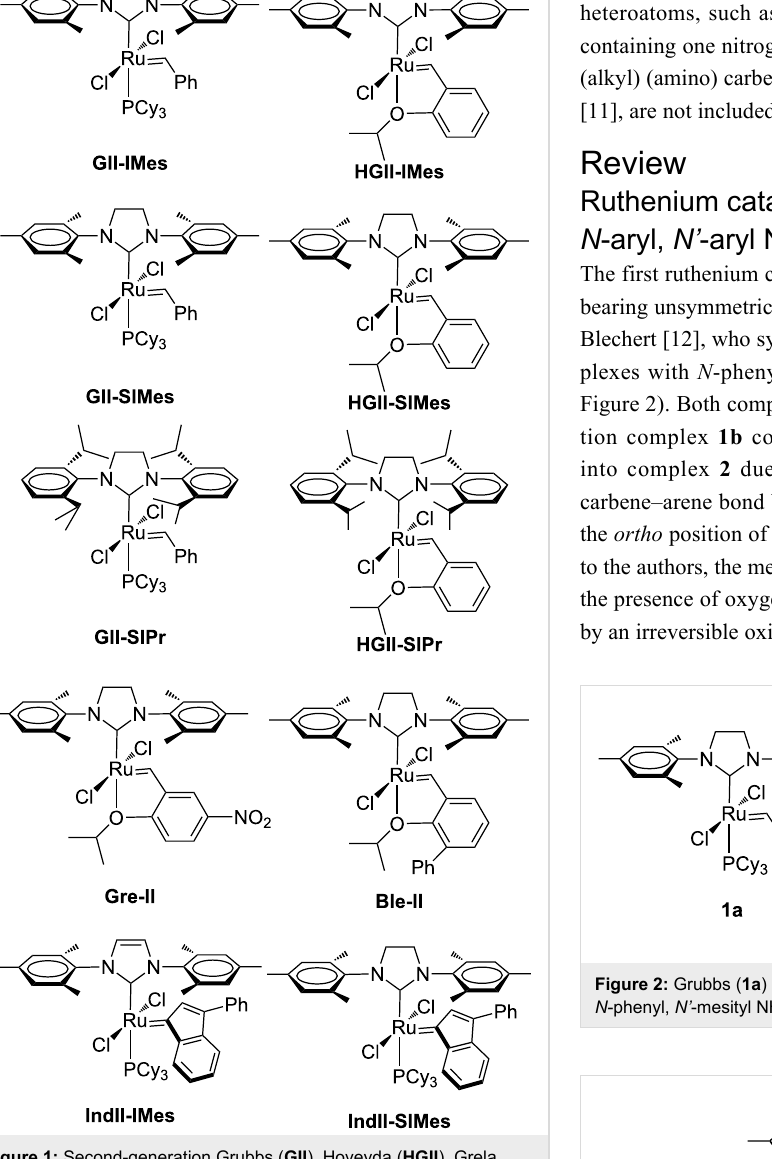
Figure 1: Second-generation Grubbs ( GII ), Hoveyda ( HGII ), Grela ( Gre - II ), Blechert ( Ble - II ) and indenylidene-type ( IndII ) catalysts with symmetrical NHCs.